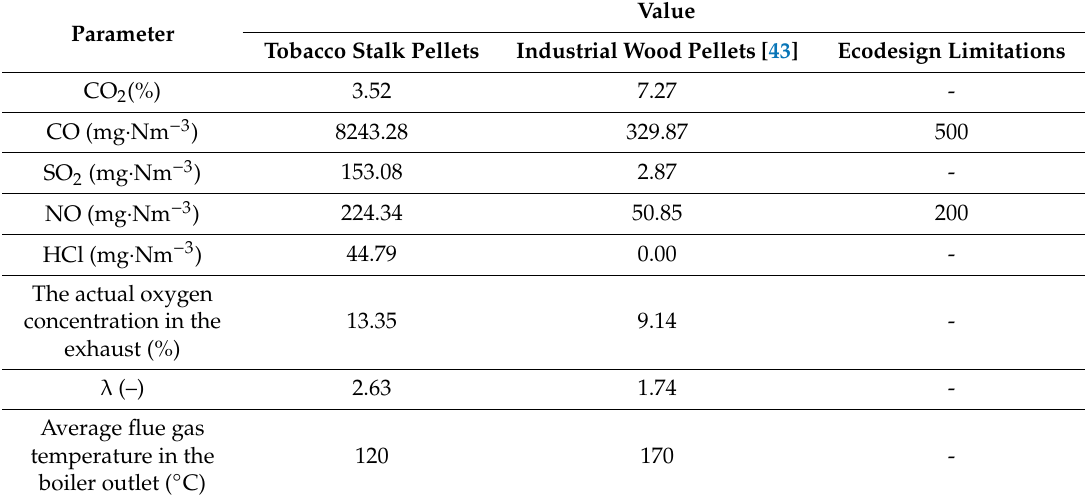
Table 4. Flue gas composition and conditions of combustion of tobacco